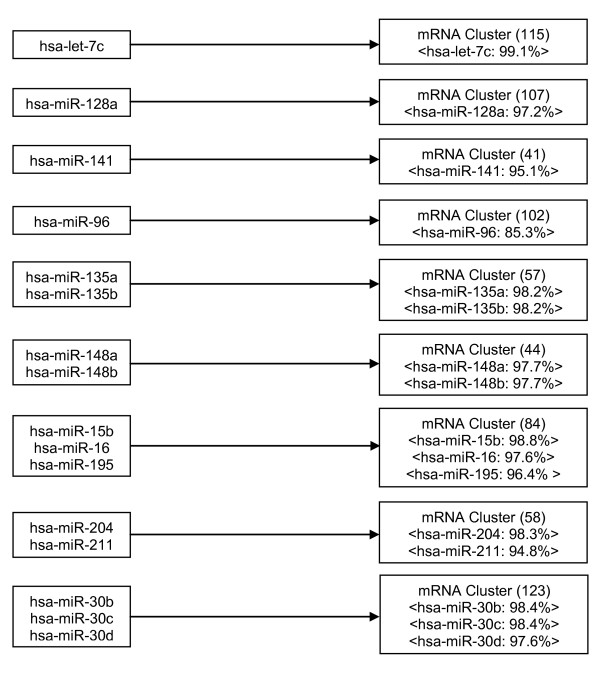
Enriched miRmR modules for the timecourse data set. For mRNA clusters, the number of mRNAs is mentioned in brackets. The notation <φ: κ> implies that miRNA φ targets κ% of the mRNAs in the cluster.